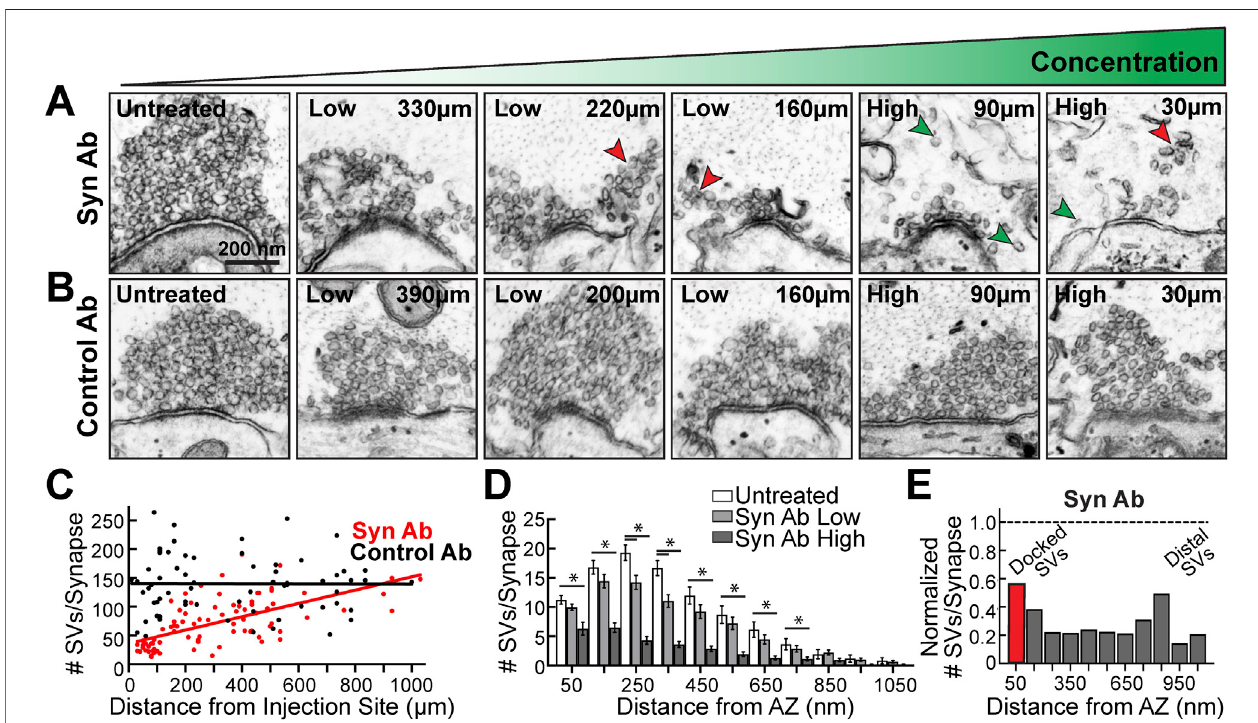
FIGURE 4 | Introduction of the pan-synuclein antibody caused a dose-dependent loss of synaptic vesicles. (A – B) Electron micrographs showing synaptic vesicle clustersatlampreyRSsynapsestreatedeitherwiththesynucleinantibody(SynAb)orControlIgGantibodies(ControlAb).Distancesfromtheinjectionsiteareindicated. While Synuclein Ab caused a progressive loss of SVs as antibody concentration increased, there was no change in the size of vesicle clusters with the Control Ab. In the presenceoftheSynucleinAb,theSVsappearedtode-clusterintosmallerSVsubclusters(redarrowheads),aswellasindividualSVs(greenarrowheads).Scalebar in A also applies to B. (C) With the Synuclein Ab, vesicle cluster sizes were dependent on the distance from the injection site, and thus antibody concentration, while no effectwasobserved withtheControlAb(SynAb: slope (cid:2) 0.1158,R 2 (cid:2) 0.394;ControlAb:slope (cid:2) − 0.0011,R 2 < 0.0001;linearregression, p < 0.0001). (D) There wasa dose-dependent effect of Synuclein Ab at all distances from the active zone (AZ) up to 800 nm. (E) Normalized vesicle distribution, which compares Synuclein Ab (High concentration) to untreated control, reveals that synuclein disruption caused a 50 – 80% loss of both docked synaptic vesicles ( < 50 nm, red bar), as well as the reserve pool of distal SVs ( > 50 nm, Gy bars). Bars in D – E represent mean ± SEM from n (cid:2) 23 – 31 synapses, 2 axons/animals. Asterisks indicate statistical signi fi cance by ANOVA.